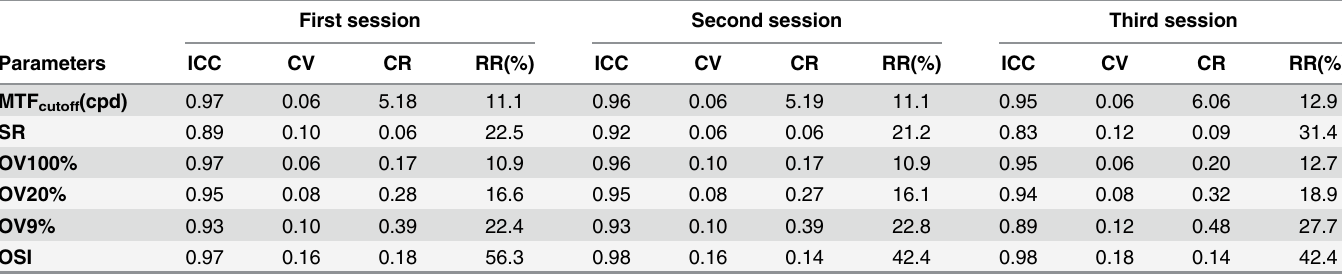
Table 2. Intrasession repeatability outcomes for the measurements in the three